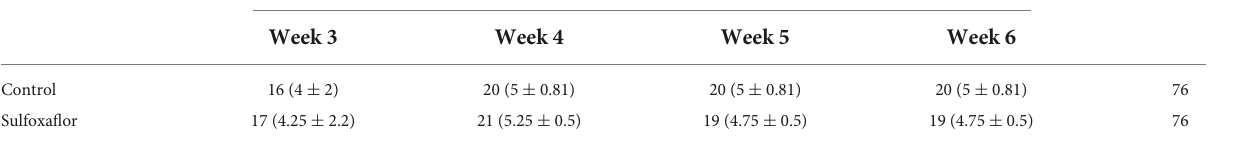
TABLE 1 Total and mean ( ± SD) number of individuals per colony from which pollen loads were